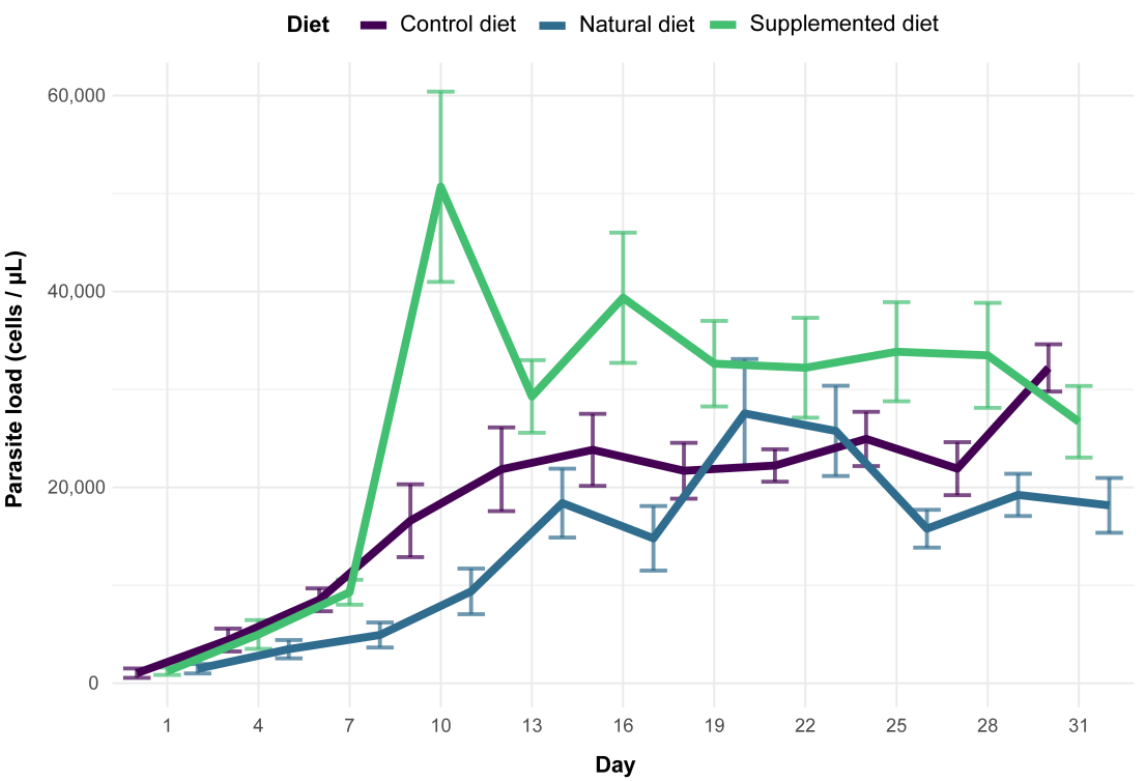
Figure 5. Parasite load among diet treatments for 31 days (mean ± SE). The first measure was tak- en three days after inoculation (day 1 in the figure) and the following measures were then taken every three